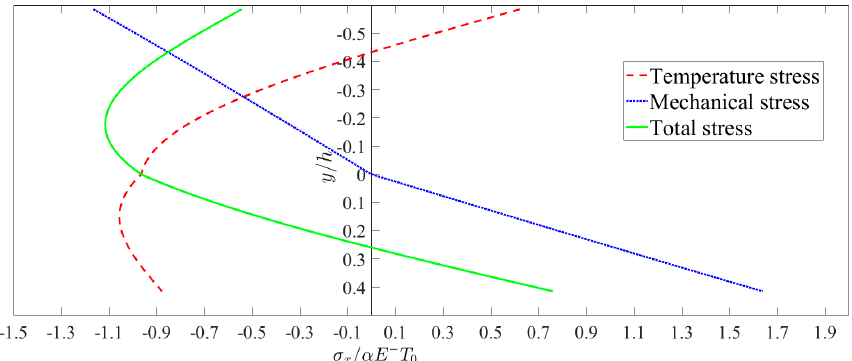
Figure 4. Stress composition when E + = 2 E − and α E − T 0 / q = 20.